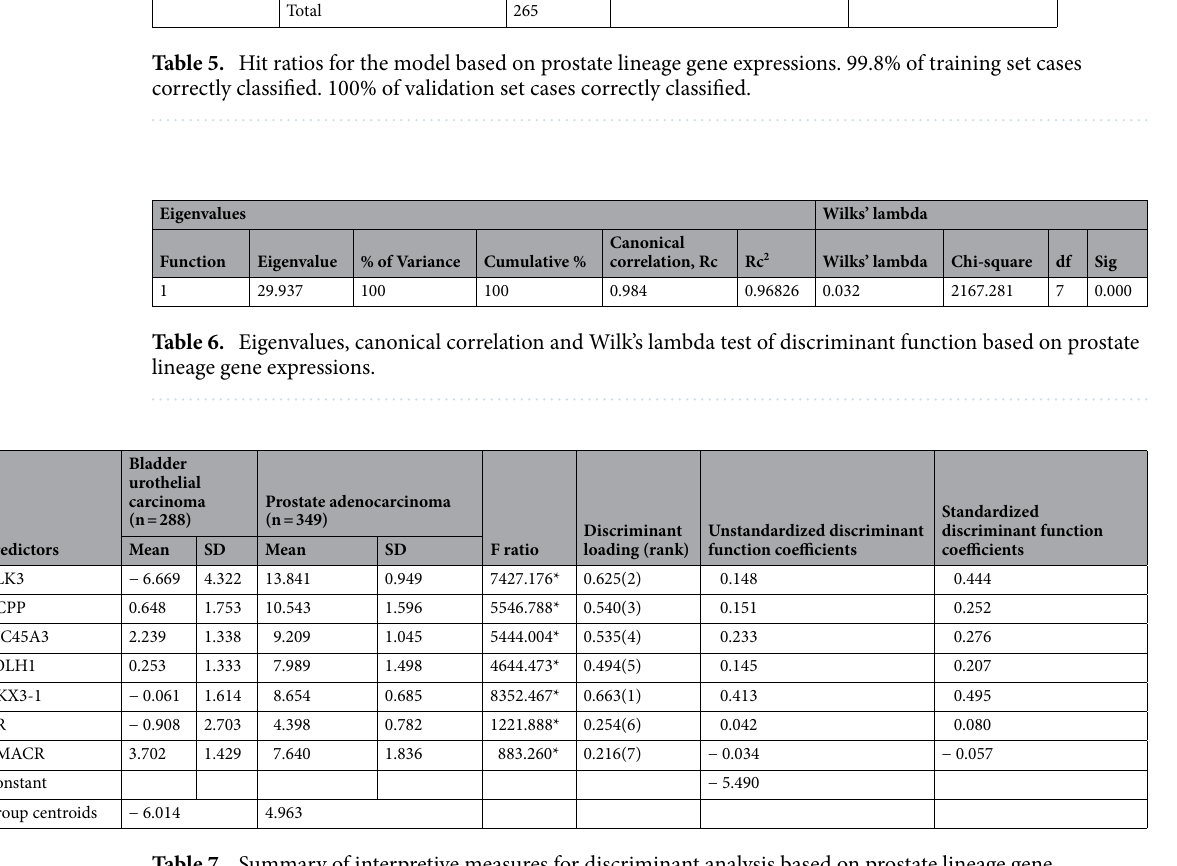
Table 7. Summary of interpretive measures for discriminant analysis based on prostate lineage gene expressions. Discriminant function, D1 = 0.148(KLK3) + 0.151(ACPP) + 0.233(SLC45A3) +